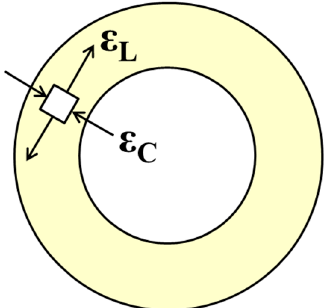
Figure 9. Schematic of the strain state in the cross section of a pipe joint.